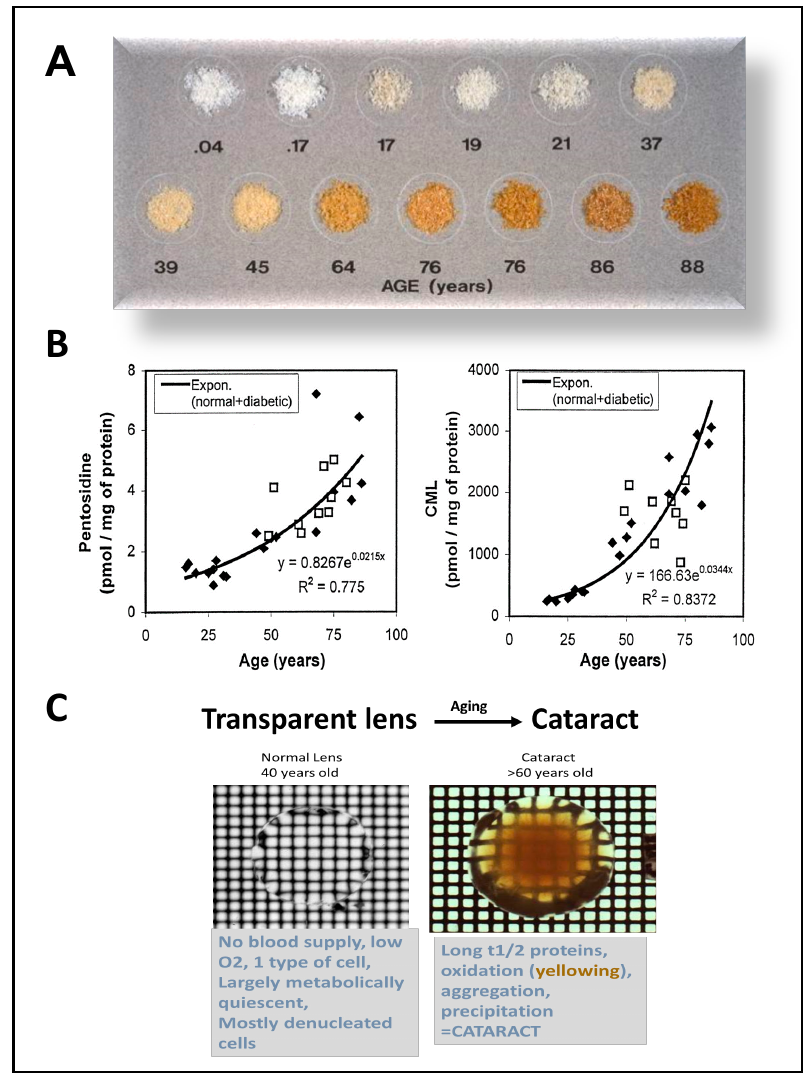
Figure 2. Aging promotes the accumulation of AGEs throughout the body. ( A ) Age-dependent changes in costal cartilage isolated at autopsy from donors of various ages (reprinted with permission of Dr. Baynes) [44]. ( B ) Level of pentosidine (left) and N ε -(carboxymethyl)-lysine (CML) (right) in lens crystallins from diabetic ( (cid:4) ) and non-diabetic ( (cid:7) ) subjects as a function of age (reprinted with permission of Dr. Monnier) [46]. ( C ) Transillumination of isolated lenses: Normal lens from young donor (left) and cataractous lens from older donor (right). Lenses were placed in a culture dish that had a grid etched in its bottom surface. The dish was placed on the stage of a dissecting microscope and viewed with transmitted light. Note the degree of yellowing and opacity in the cataractous